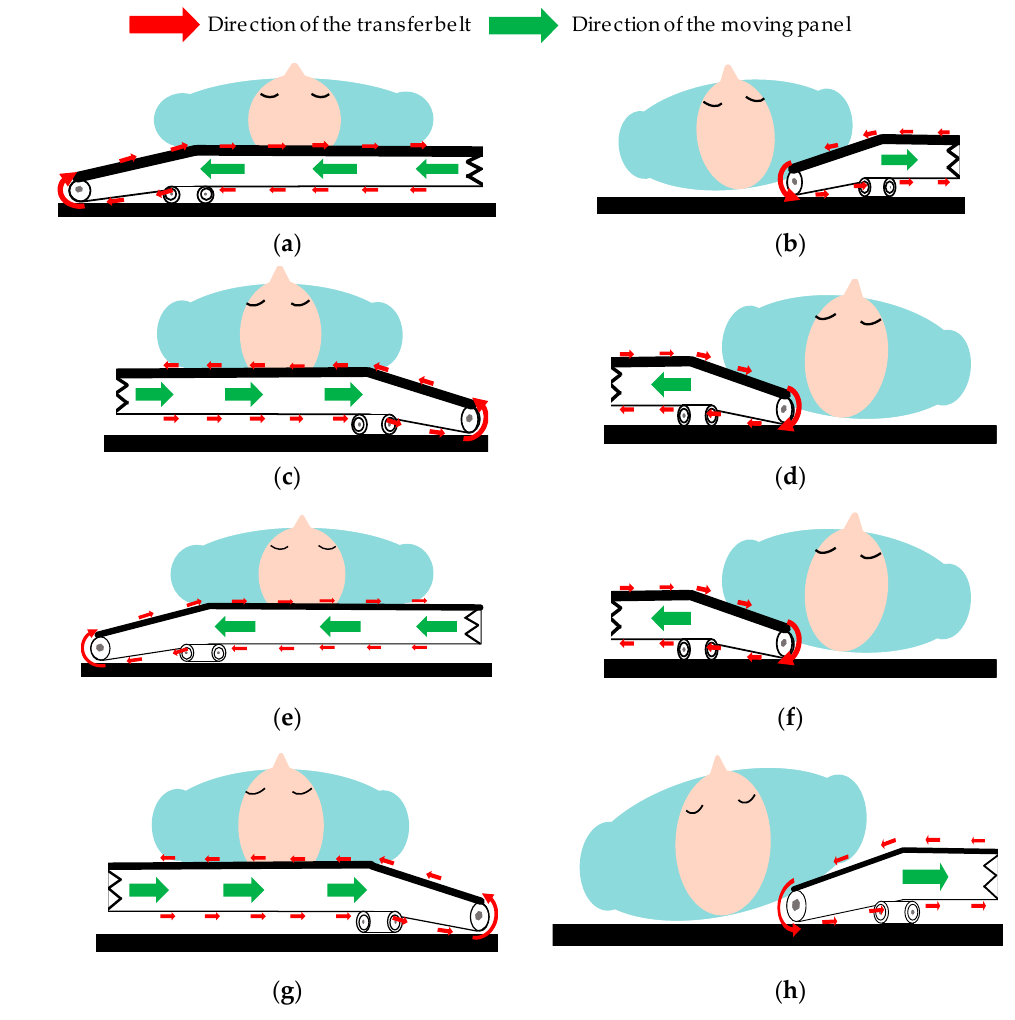
Figure 3. Working principles diagram of patient transfer robot. ( a ) Lifting and transferring patient from the left side of the sickbed; ( b ) placing the patient down from the left of the sickbed; ( c ) lifting and transferring patient from the right side of the sickbed; ( d ) placing the patient down from the right side of the sickbed; ( e ) Lifting and transferring patient from the left side of the sickbed; ( f ) placing the patient down from the right side of the sickbed; ( g ) lifting and transferring the patient from the right side of the sickbed; ( h ) placing the patient down from the left of the